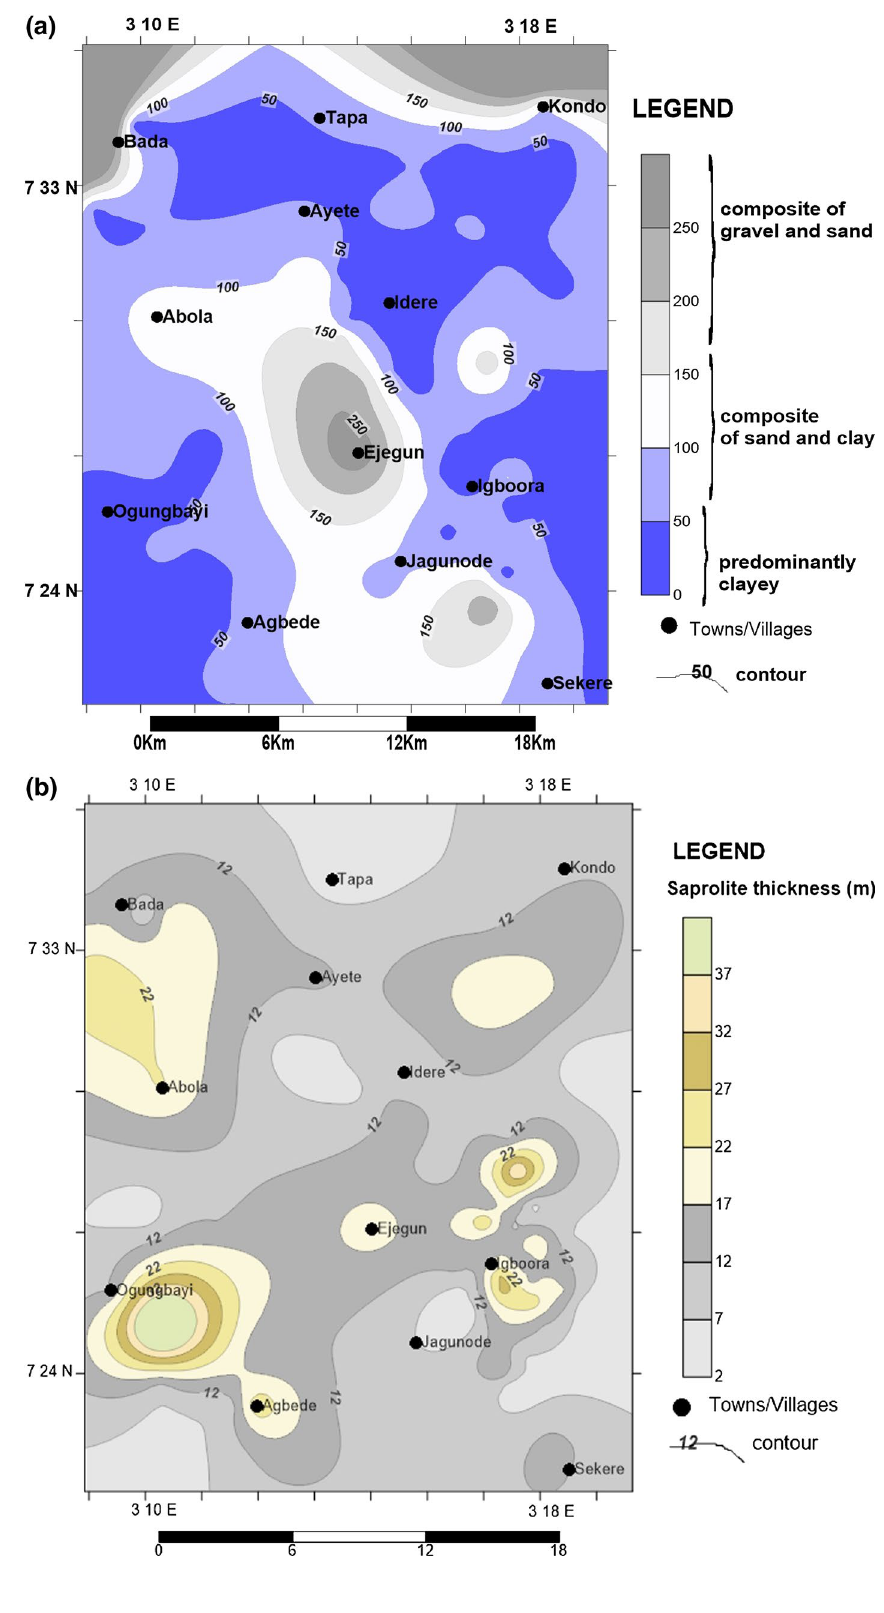
Fig. 7 a Resistivity map of the study area. b Saprolite thickness map of the